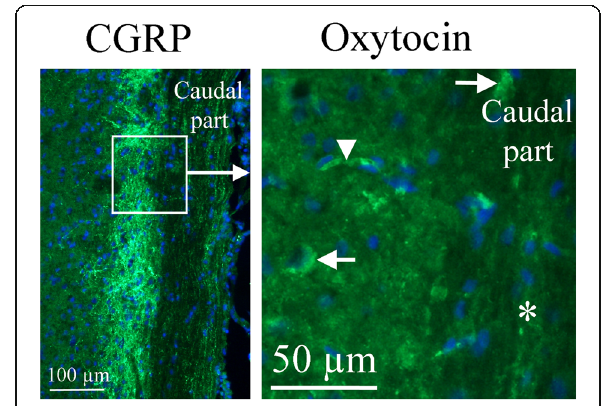
Fig. 10 Oxytocin immunohistochemistry of the Spinal trigeminal nucleus. To the right, oxytocin immunohistochemistry is shown. A few cell bodies (arrows) express oxytocin in the Sp5. No immunoreactivity was found in fibers (asterisk). The arrowhead points at a stained capillary. On the left, CGRP expression in this region [25] is shown for comparison. The square in the left panel indicates the approximate location of the area presented in the right